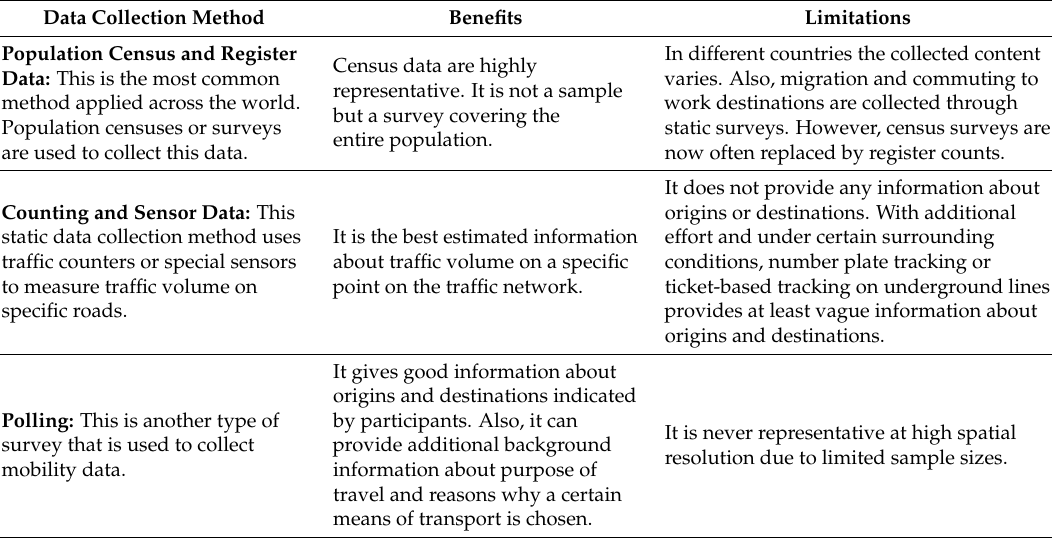
Table 1. Conventional data collection methods for population distribution and mobility patterns. Data Collection Method